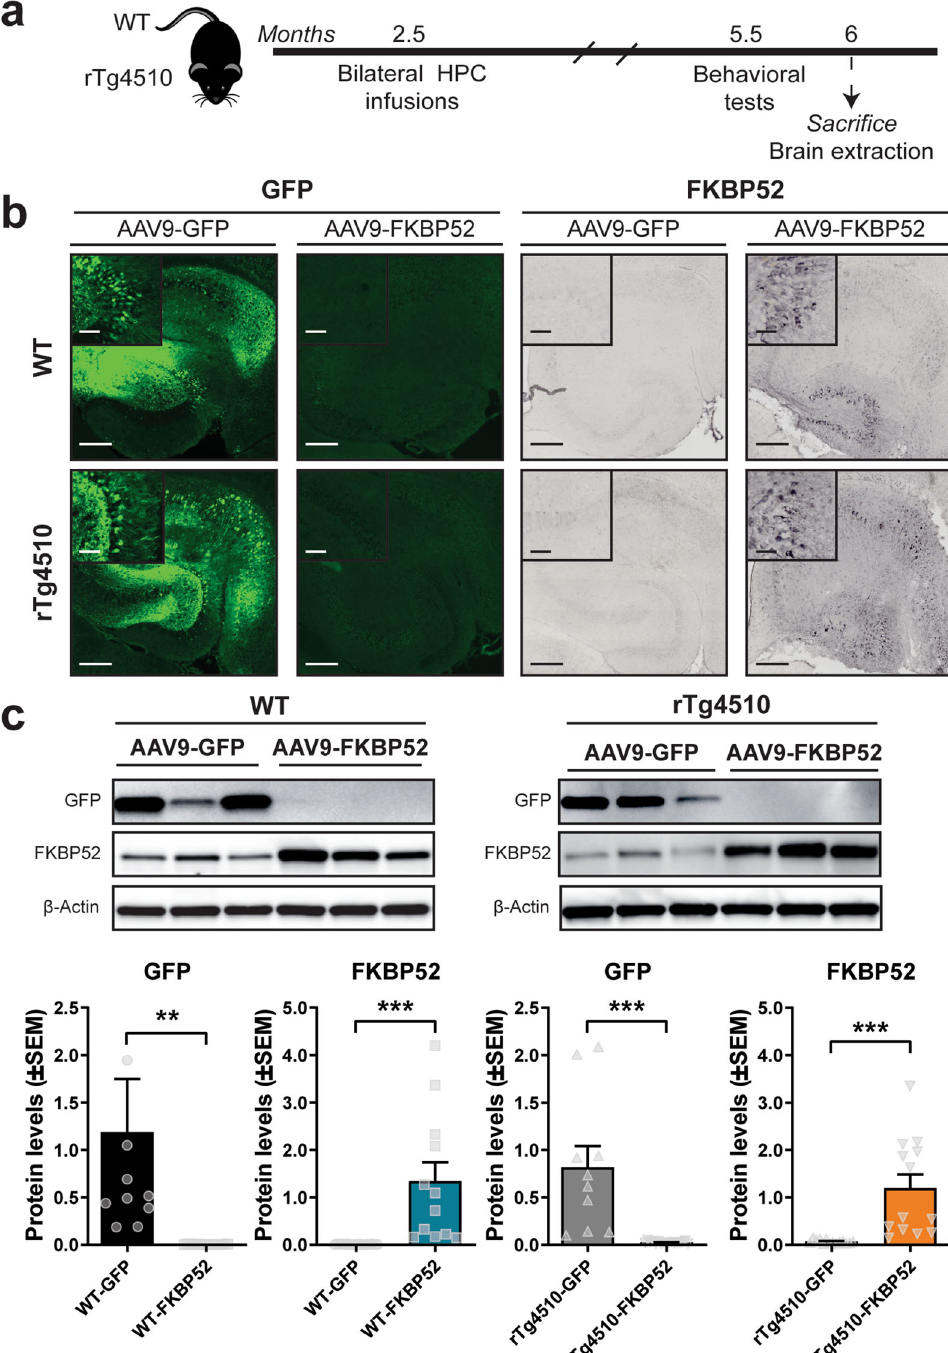
Fig. 2 Experimental design and con fi rmation of GFP and FKBP52 overexpression in the hippocampus. a Timeline of bilateral hippocampal AAV injections and experiments performed in WT and rTg4510 mice. b Representative images of AAV9-GFP and AAV9-FKBP52 hippocampal sections after 3 months of viral expression. c Representative Western blots and quanti fi cation of GFP and FKBP52 overexpression in these animals. Wild-type mice [ n = 16], rTg4510 mice [ n = 16]. Protein levels were normalized to ß-Actin and analyzed by unpaired t test, where statistical signi fi cance is represented by ** p < 0.01 and *** p < 0.001. Scale bar represents 200 µm; inset scale represents 20 µm. AAV9 adeno- associated virus serotype 9, GFP green fl uorescent protein, WT wild-type, HPC